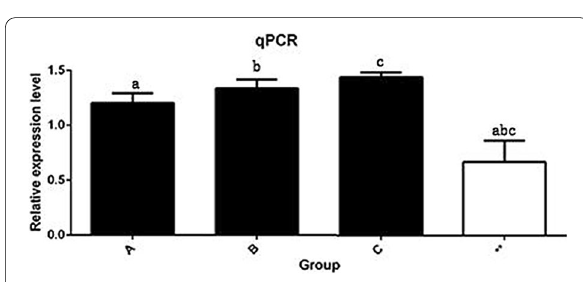
Fig. 5 Bar chart of the qPCR results. a Coprococcus was treated with a concentration of 1 10 6 , b Coprococcus was treated with × a concentration of 1 10 7 , c Coprococcus was treated with A × concentration of 1 10 8 , ** represents the blank treatment control ×